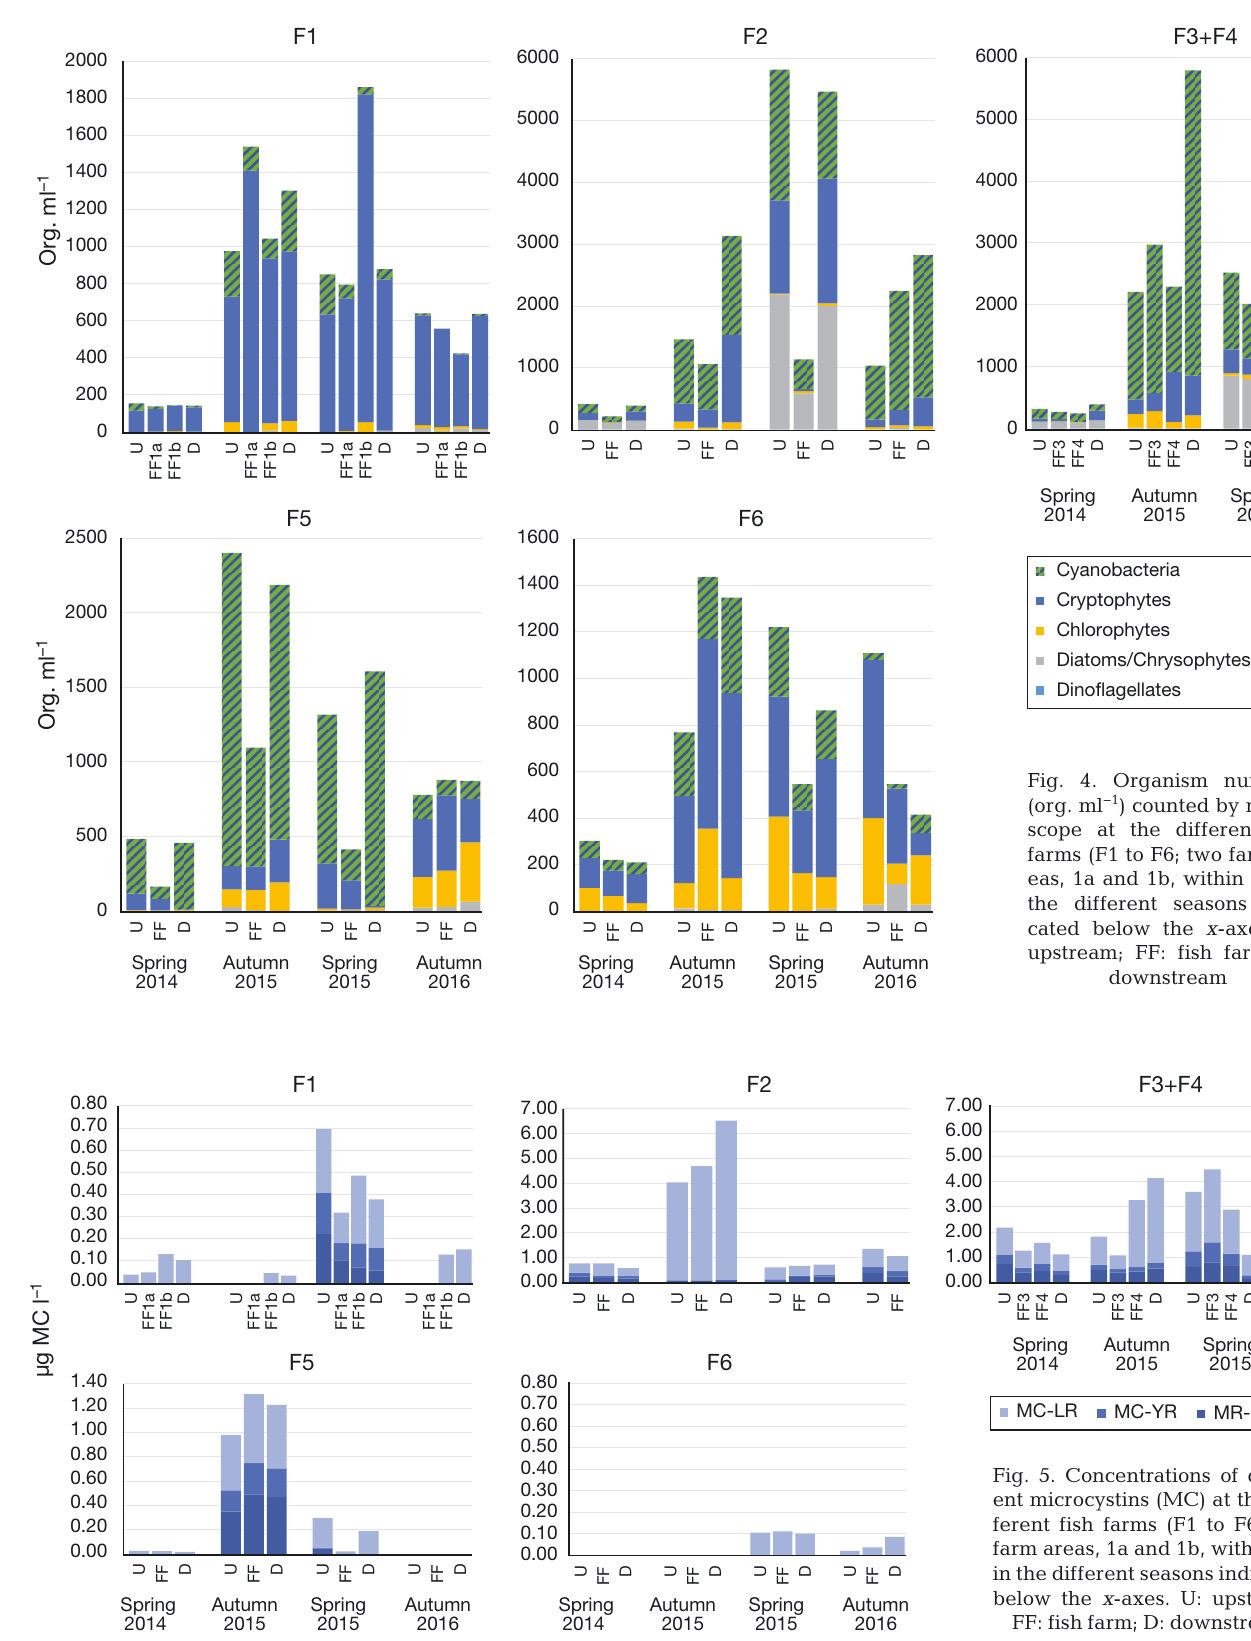
Fig. 5. Concentrations of differ- ent microcystins (MC) at the dif- ferent fish farms (F1 to F6; two farm areas, 1a and 1b, within F1) in the different seasons indicated below the x -axes. U: upstream; FF: fish farm; D: downstream